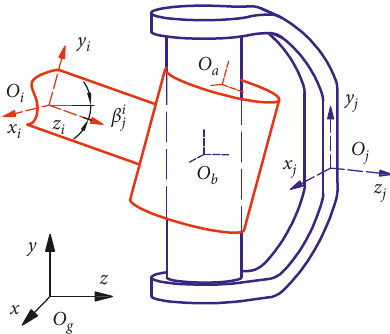
Figure 5: Coordinate systems in the 3D revolute joint with